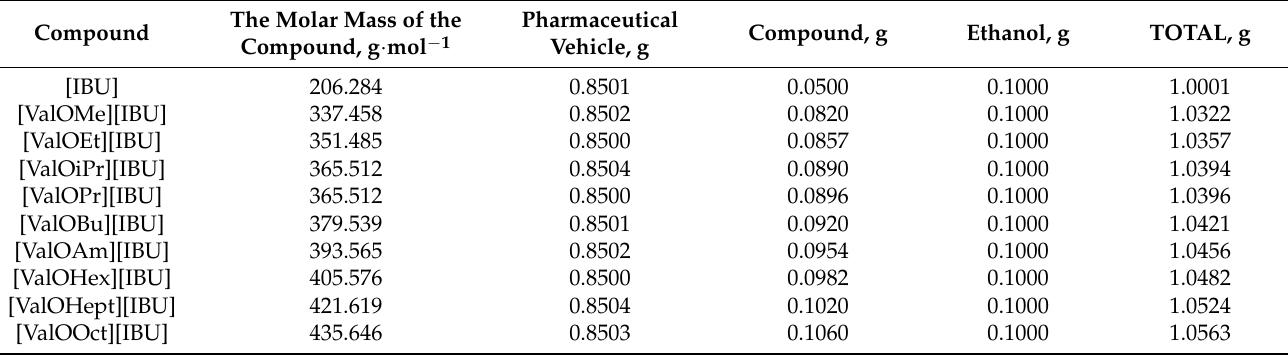
Table 2. Composition of emulsion (creams).